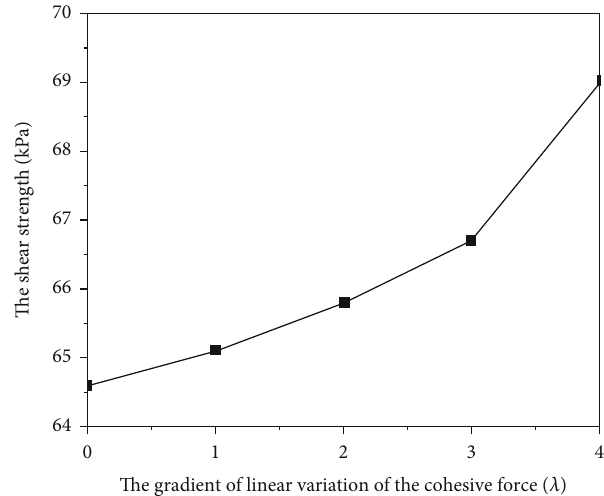
Figure 18: Variation in shear strength with the cohesion